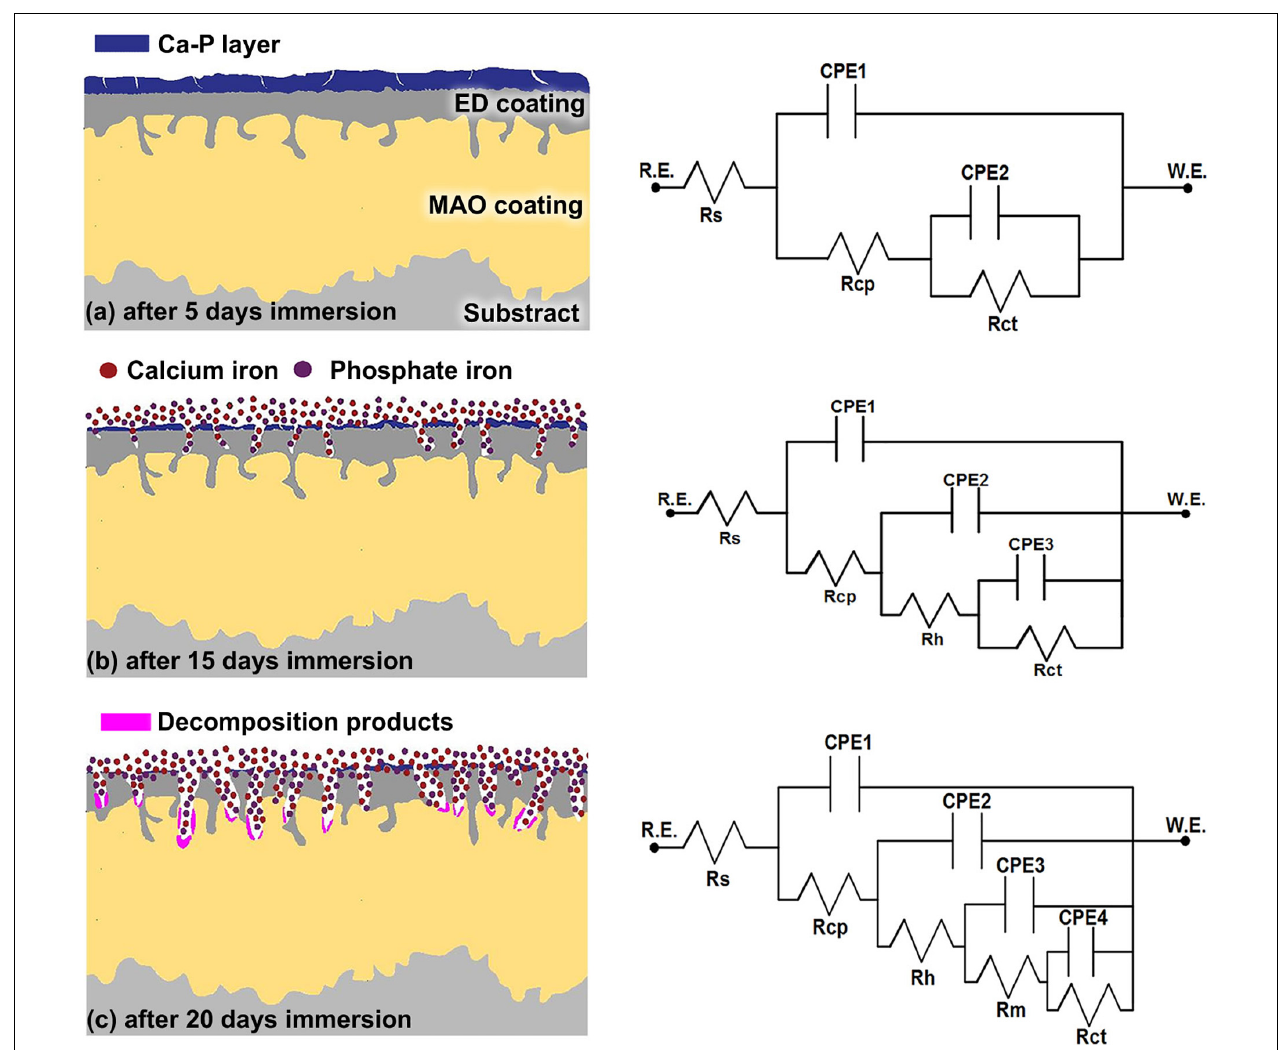
FIGURE 10 | Equivalent circuit models of MAO-ED samples in different stages in SBF: (a) Deposition product formation stage, (b) Crack propagation stage, (c) Internal corrosion